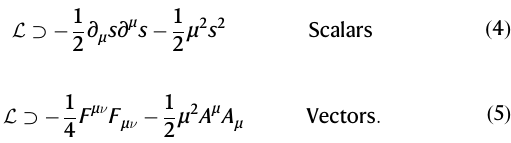
Boundariesoftheredandblueregions:maximalBHspinsallowedbythin-diskspin- up and superradiant spin-down due to scalars ( a ) and vectors ( b ), for two selected ULB masses μ =5×10 − 19 eV (red) and μ =10 − 19 eV (blue). Star: maximal Hills mass allowed by an ULB with mass μ =10 − 19